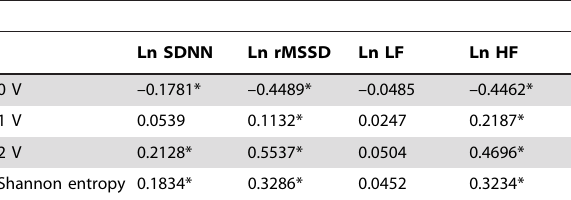
Table 5. Pearson’s correlation between linear and non-linear indices in NAFLD and control